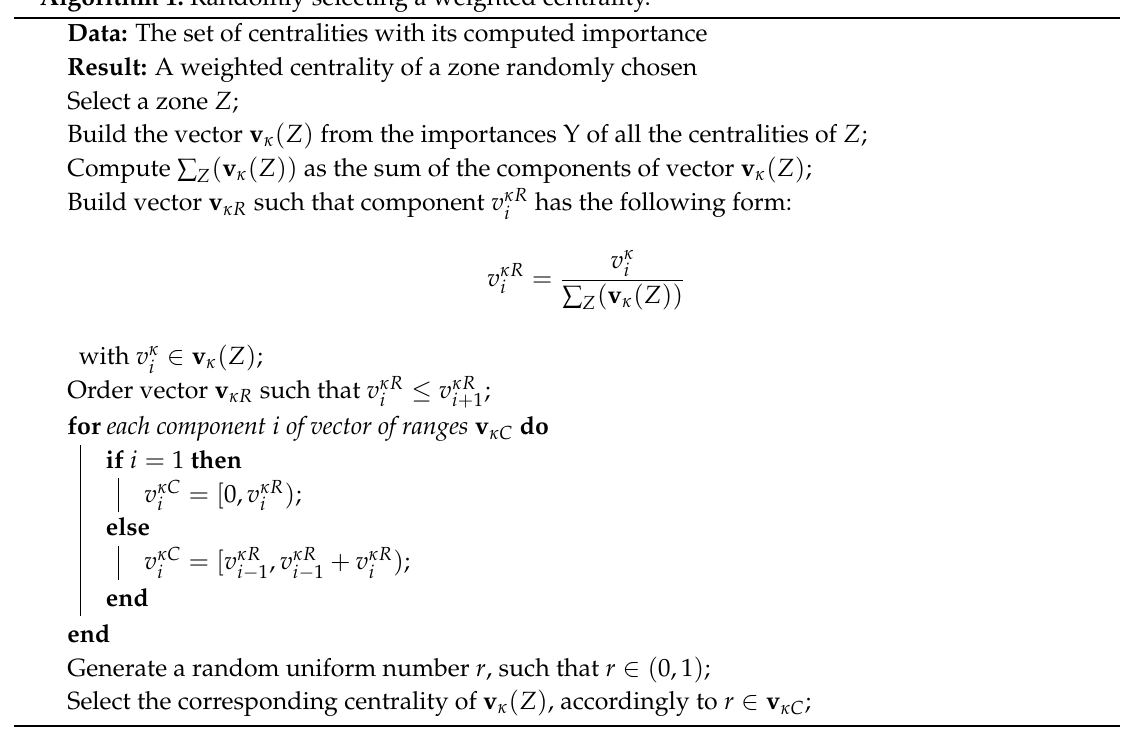
Algorithm 1: Randomly selecting a weighted